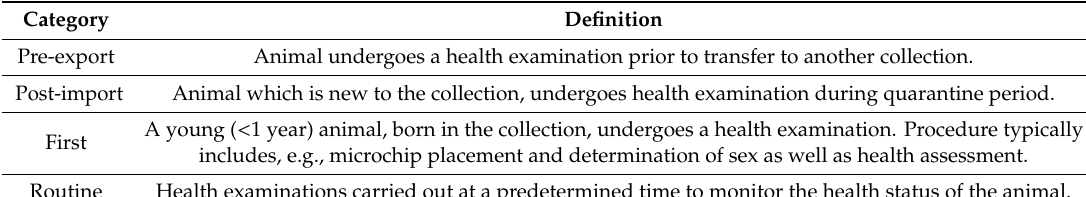
Table 2. Definitions of health check categories.